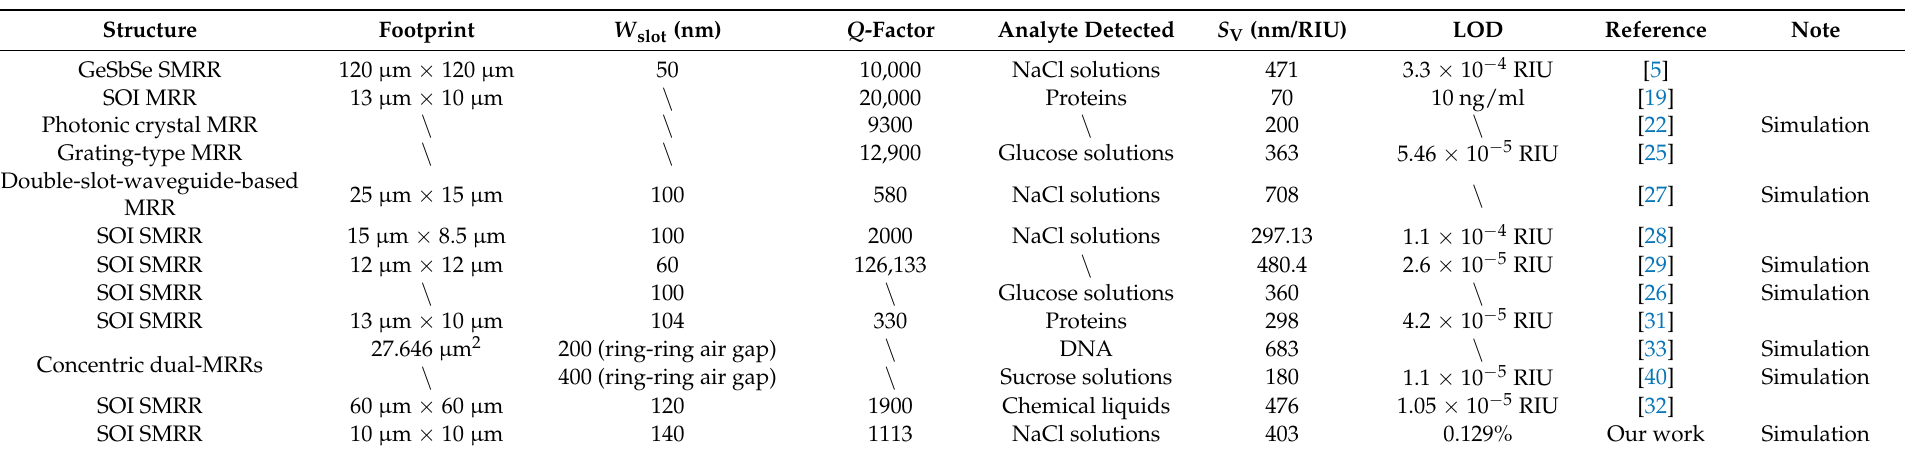
Table 2. Comparison of different MRR